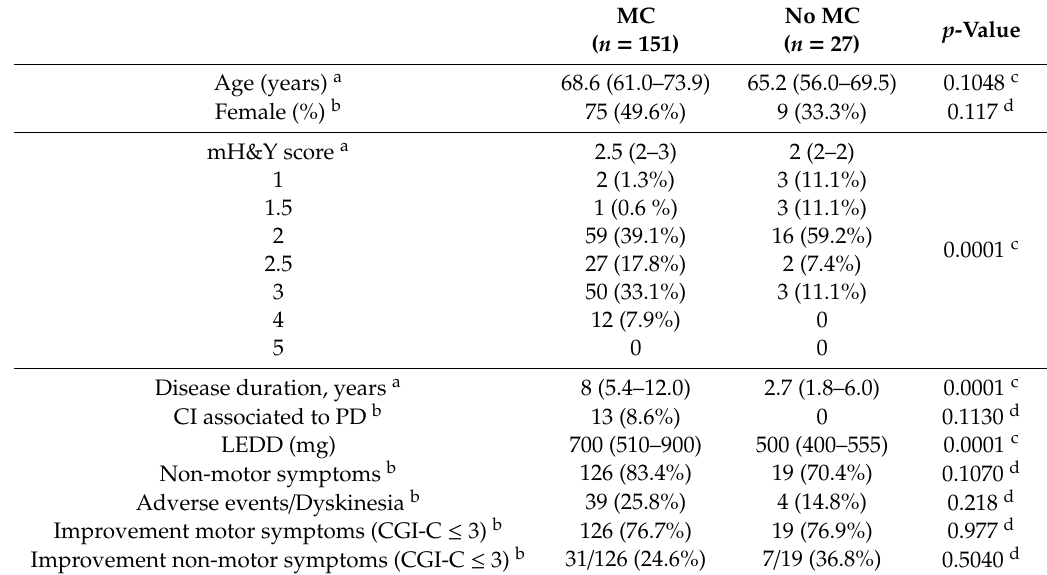
Table 6. Between patients with Motor Complications (MC) and without